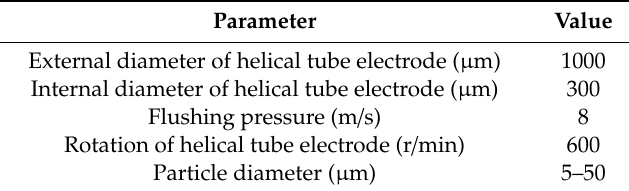
Table 1. Parameters of flow-field simulation for different helically structured tube electrodes.